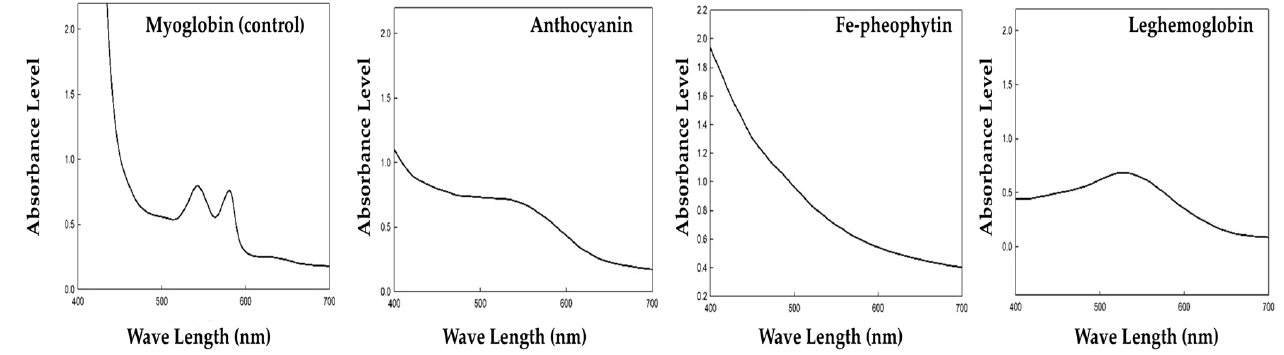
Figure 8. Absorbance level of pigment samples.